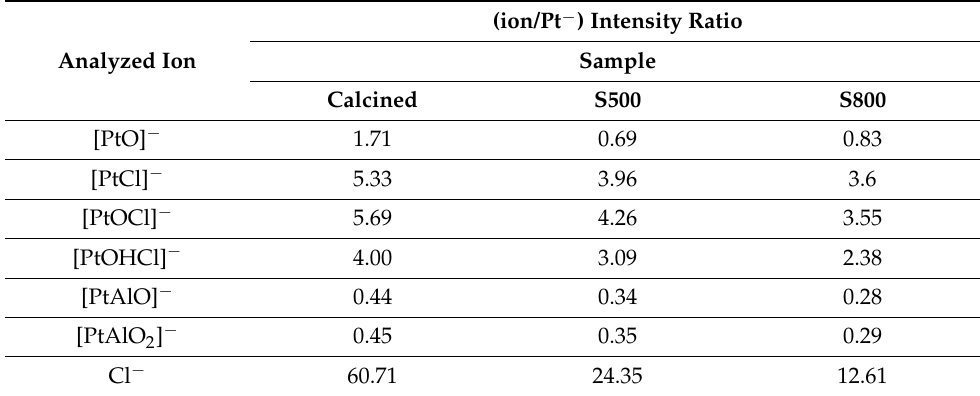
Table 2. The TOF-SIMS intensity levels of selected ions for 1%Pt/Al 2 O 3